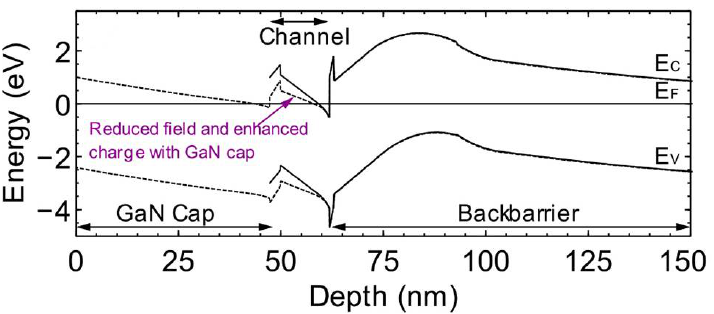
Figure 9. Energy band diagram comparing the N-polar GaN HEMT with and without a GaN cap. Reprinted with permission from Ref. [53]. Copyright 2018 by IEEE.